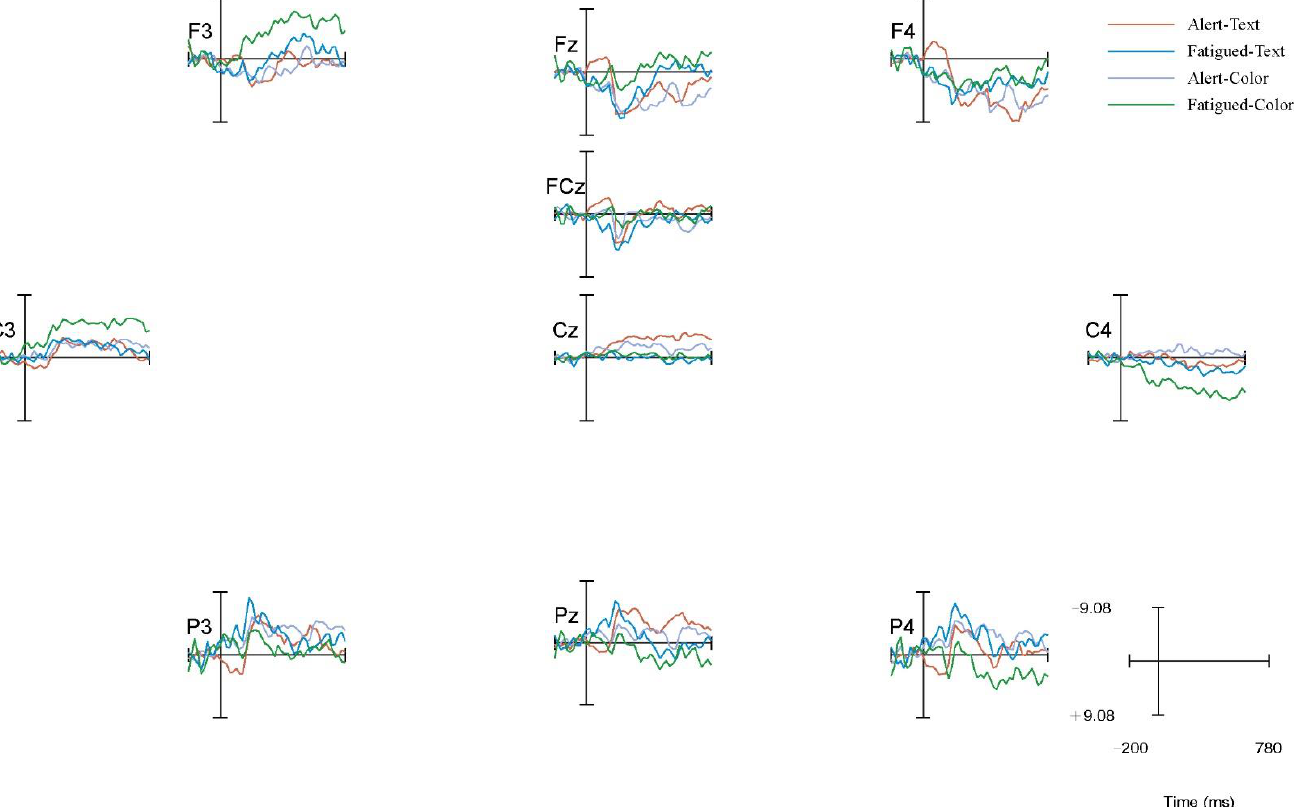
Figure 7. The total average waveform of the oddball paradigm P200.